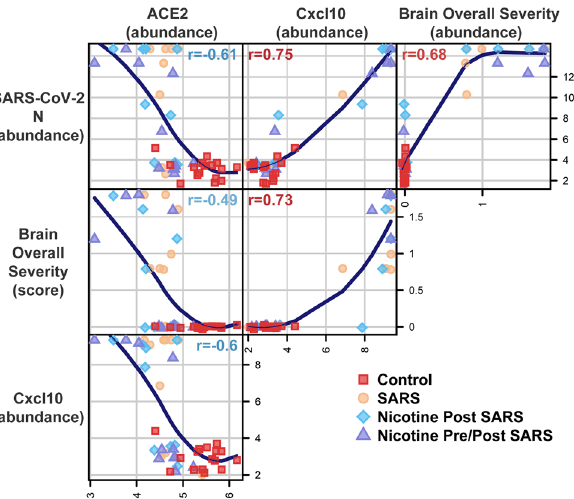
Figure 6. Expression of SARS-CoV-2 RNA in the brain is correlated with pathology gene expression, brain lesions, and ACE2 expression. A scatterplot matrix showing pairwise combinations of variables including: log2 normalized gene expression for SARS-CoV-2 N, Cxcl10, and human ACE2; and overall brain neuropathology severity. The Spearman correlation is displayed inside each scatterplot panel, calculated using data across all groups. A loess curve is shown as a visual aid for each panel. Experimental groups are indicated by point shape and color. Labels above plot panel indicate x-axis measurements, and labels along the right of plot panels indicate y-axis measurements. SARS-CoV-2 N and Cxcl10 genes were chosen to represent SARS infection and neuropathology, respectively, as these gene transcripts were the most robustly up-regulated among responder